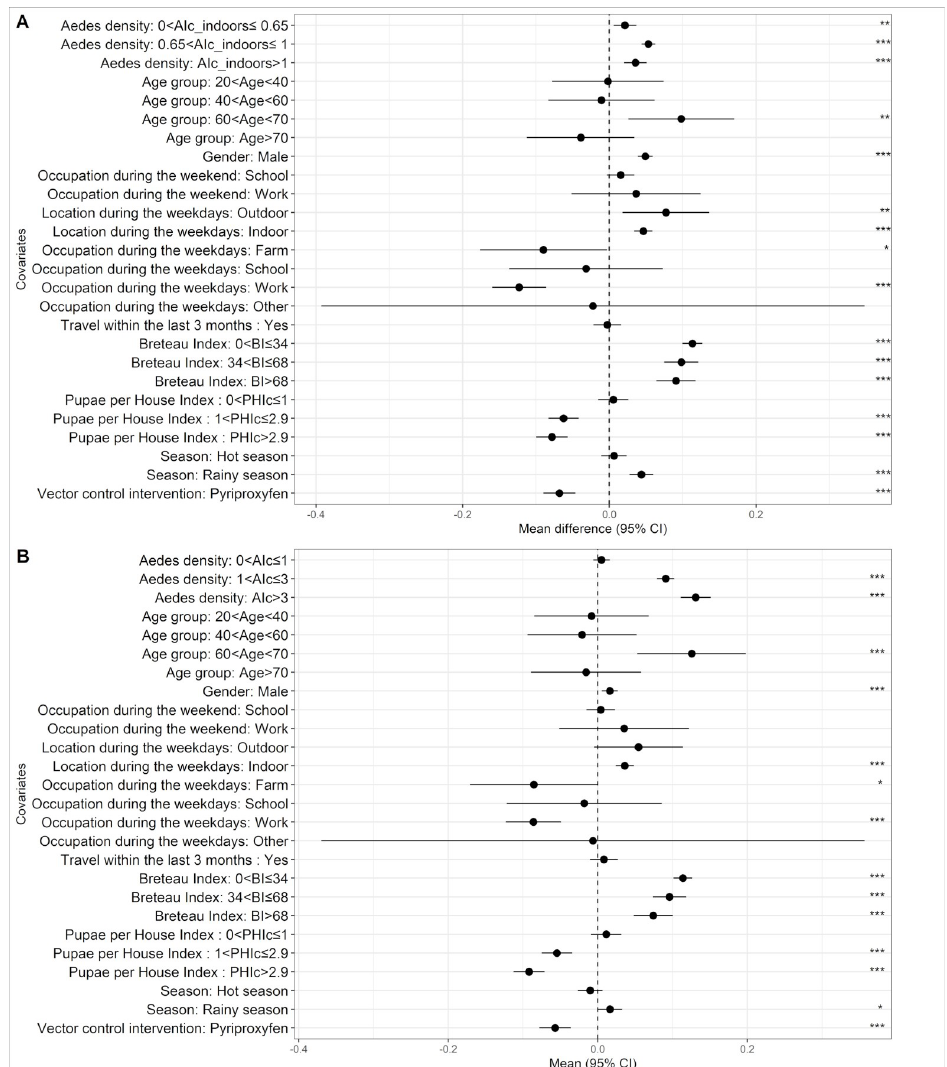
Fig 4. Multivariate analysis of MEI, human immune response to the Nterm-34 kDa salivary. (A) Adult Aedes indoors index only multivariate model. (B) Adult Aedes multivariate